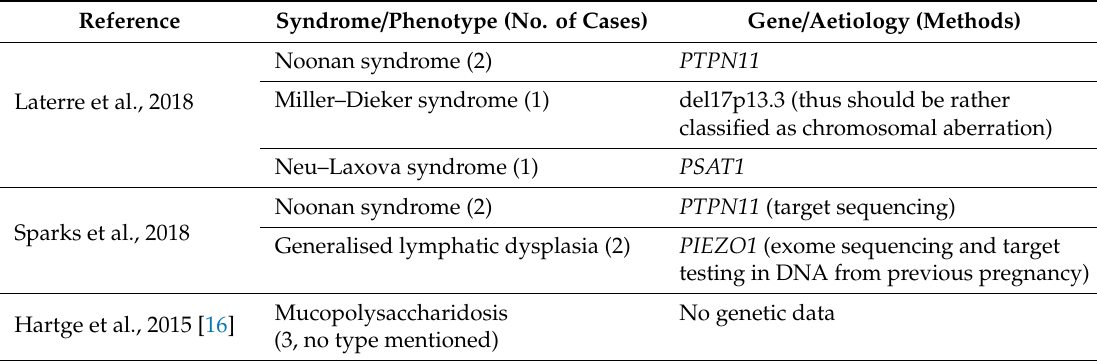
Table 2. Several syndromes related to nonimmune